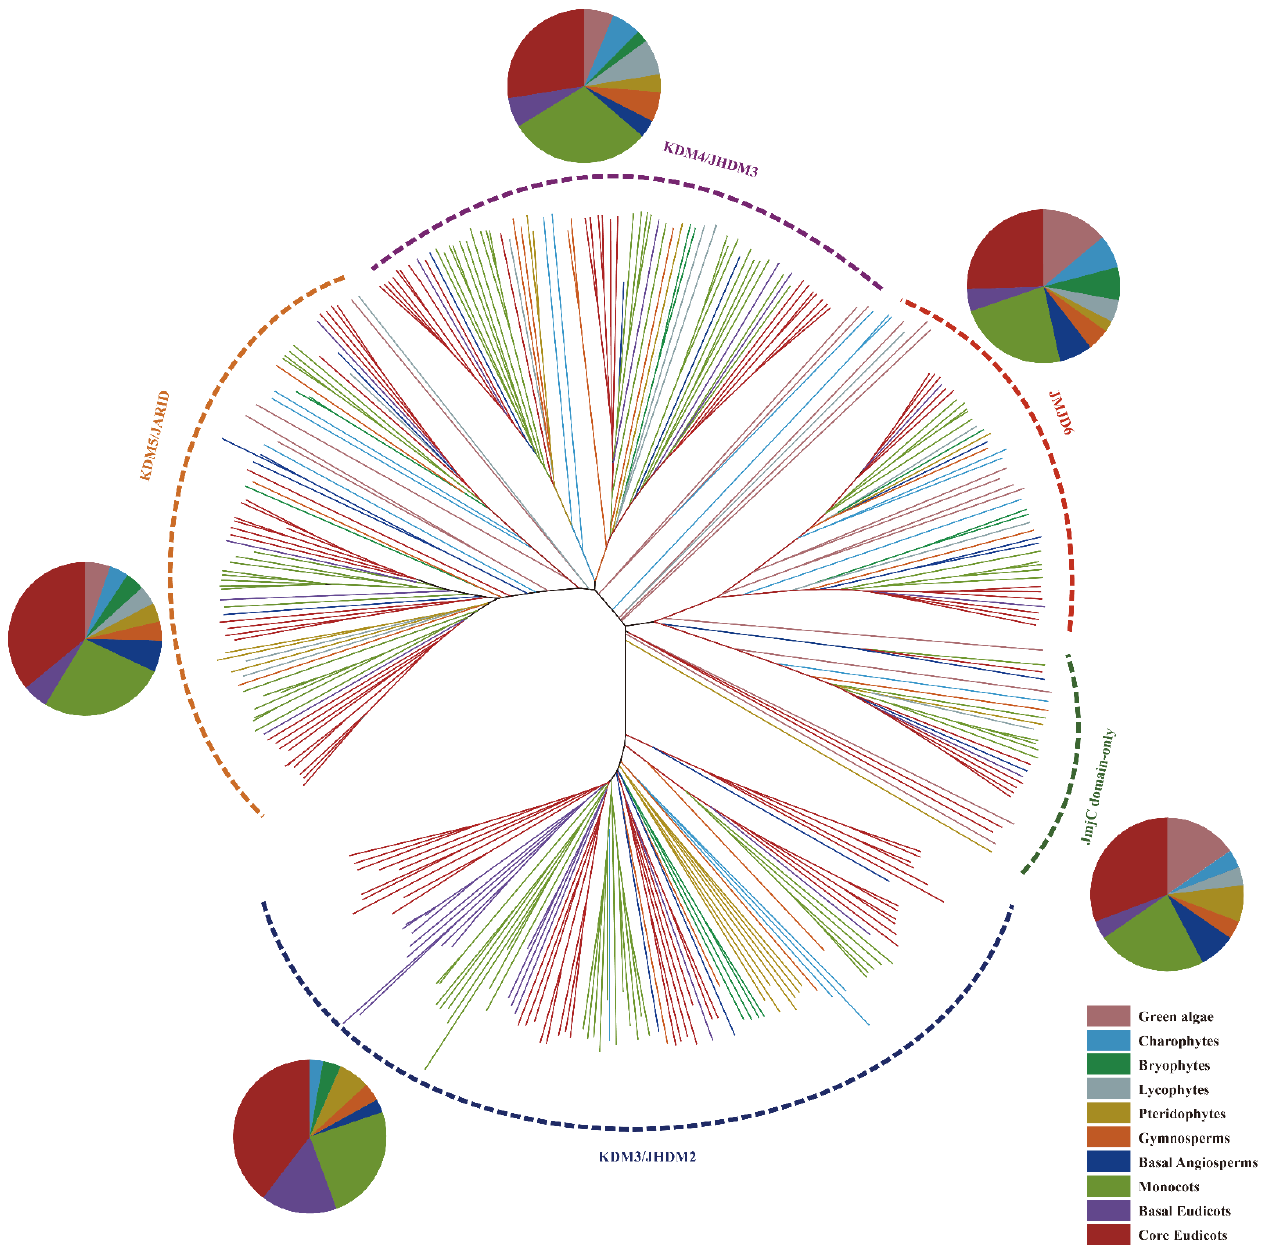
Figure 2. Phylogenetic tree of JmjC proteins in 21 plant species. JmjC s are divided into five subfamilies, which are represented by arcs of different colors. The lines of different colors in the evolutionary tree represent the JmjC s of 10 different lineages. The color of the pie chart in the figure corresponds to the color of the JmjC s in the evolutionary tree.